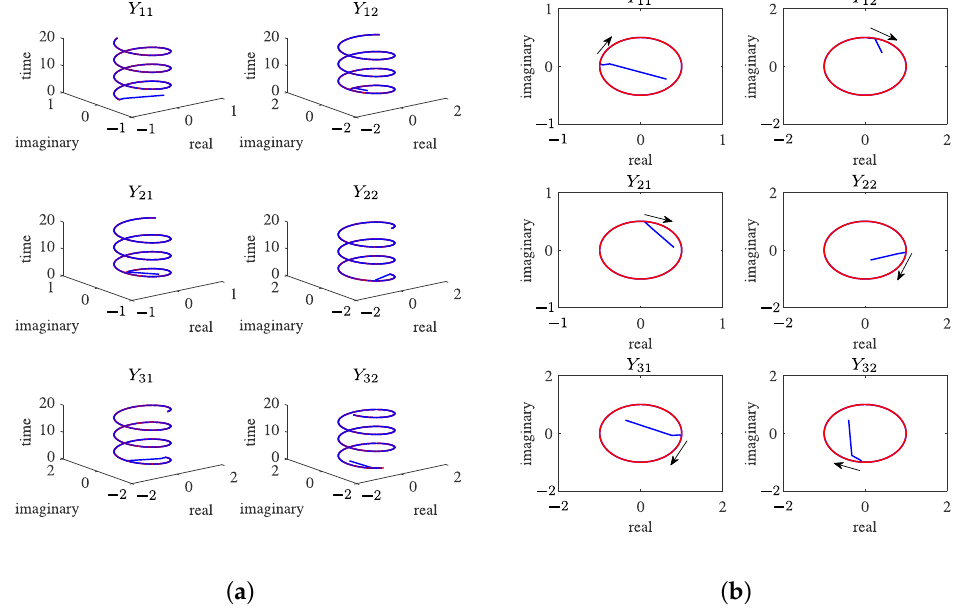
Figure 1. Dynamic characteristics of Y ( t ) synthesized by the proposed DFZNN with two activation types. ( a ) the DFZNN model with the activation type I; ( b ) profile synthesized by the DFZNN model with the activation type